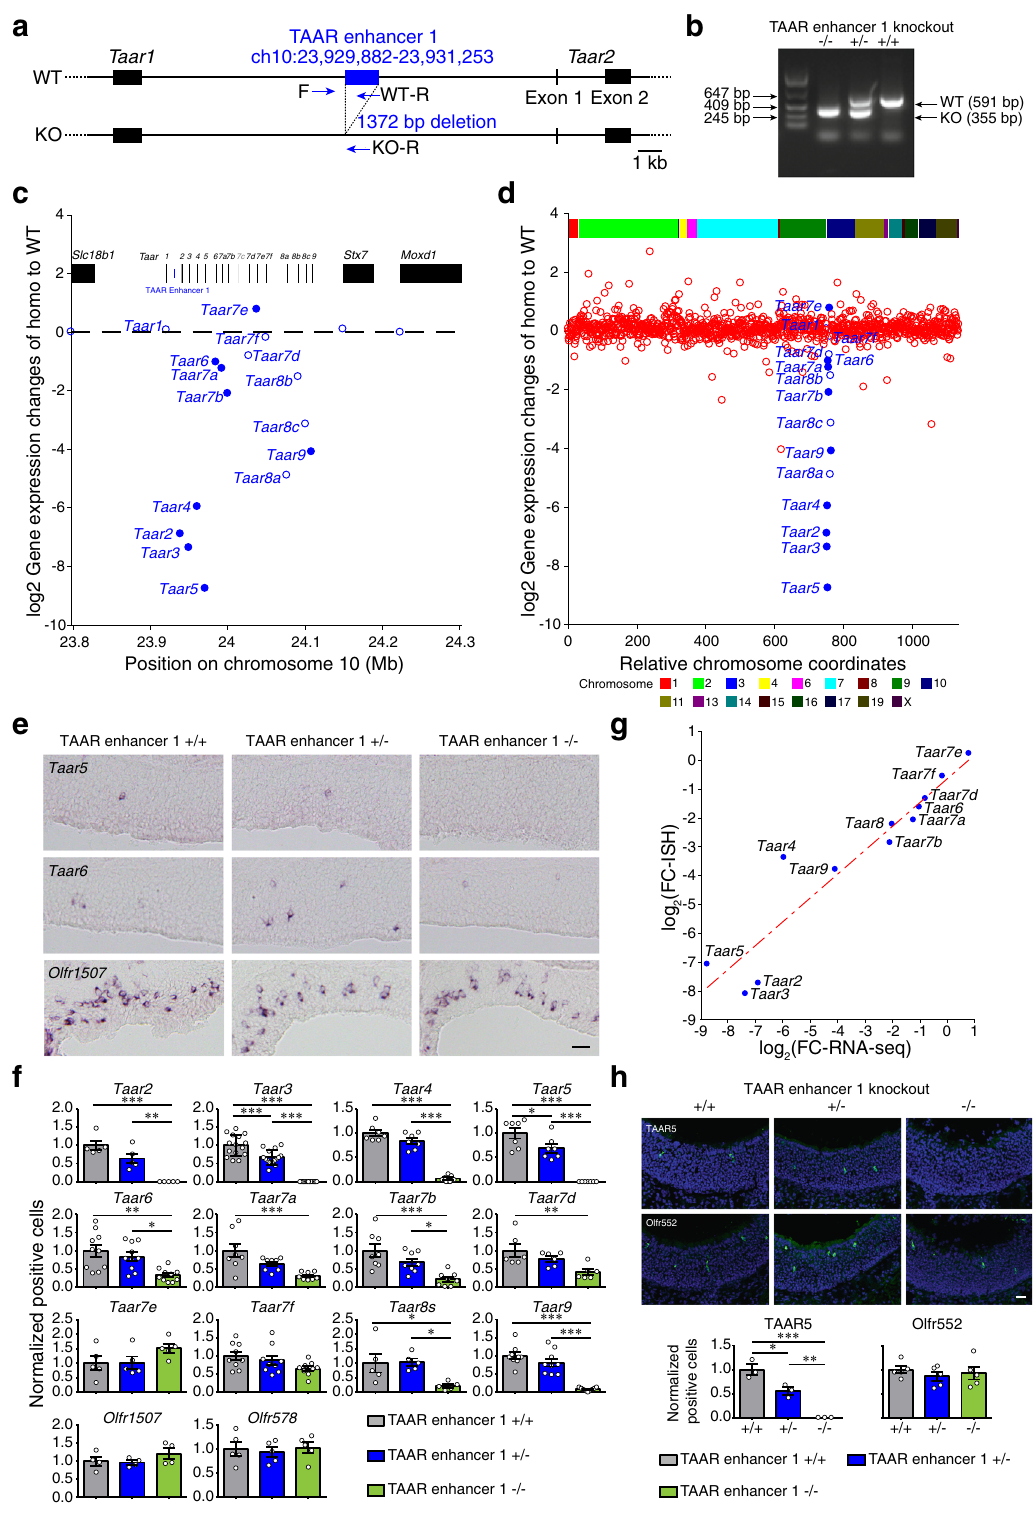
Table 4). The changes in the numbers of TAAR OSNs are in homozygous and wild-type TAAR enhancer 2 knockout mice positive linear correlation with changes in mRNA expression (Fig. 5e, f). Comparison between the phenotypes of TAAR from RNA-seq data (Pearson correlation coef fi cient r = 0.88, p = enhancer 1 and TAAR enhancer 2 knockout mice showed that 0.0001), suggesting that TAAR enhancer 2 also regulates the cells expressing Taar3 and Taar5 were abolished in both probability of receptor gene choice (Supplementary Fig. 6d and knockout mice. However, we also observed subpopulations of Supplementary Table 5). As a control, we did not detect sig- TAAR OSNs in which the effects in TAAR enhancer 2 knockout ni fi cant changes of cells expressing Olfr578 and Olfr1507 between mice were different from those in TAAR enhancer 1 knockout NATURE COMMUNICATIONS| (2021) 12:3798